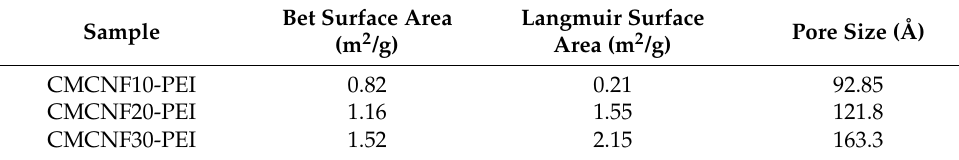
Table 2. Specific surface area and average pore size of CMCNFs-PEI aerogel.